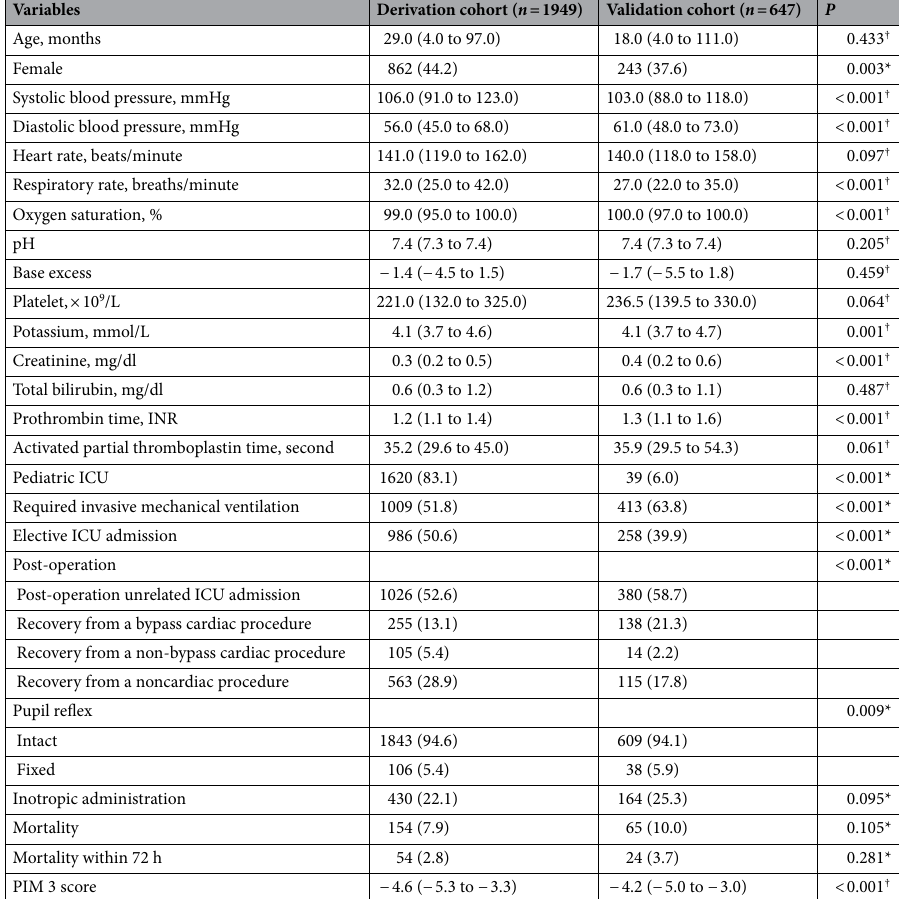
Table 1. Demographic and clinical characteristics of patients in each cohort. Continuous data are presented as median (interquartile range), and categorical data as n (%). ICU, intensive care unit; INR, international normalized ratio; PIM 3, Pediatric Index of Mortality 3. * P -values were derived through the χ 2 test for categorical variables. † P -values were derived through the Mann–Whitney U test for continuous